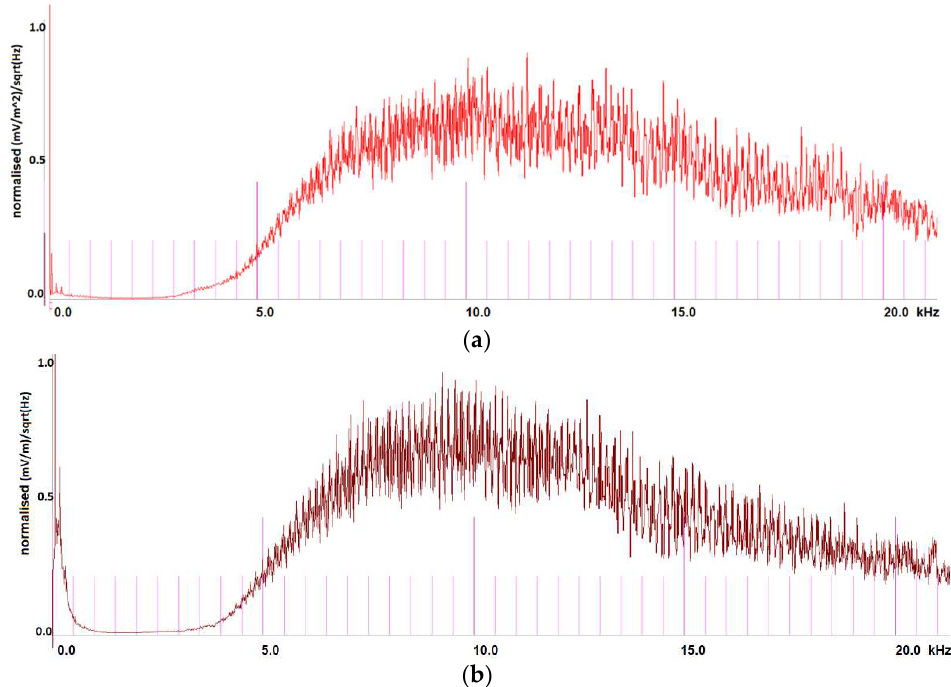
Figure 3. Airborne magnetic X-coil spectrum up to 20,000 Hz range ( a ) with the corresponded electric X-line spectrum recorded on the ground ( b ).